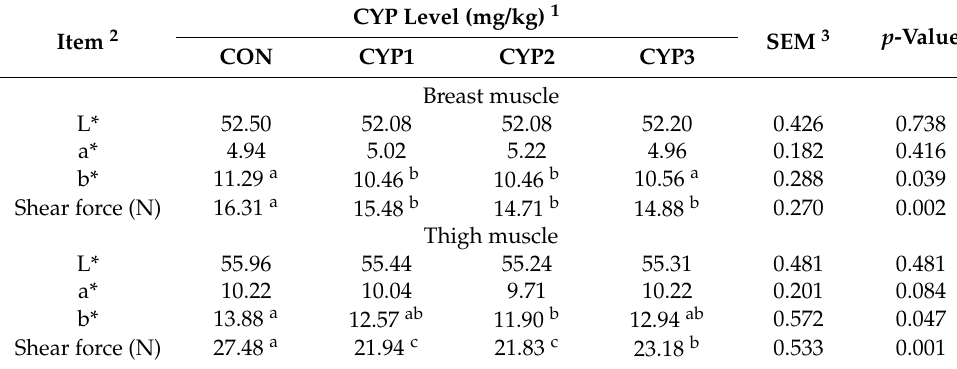
Table 4. Effects of dietary CYP supplementation on the meat quality of broilers.